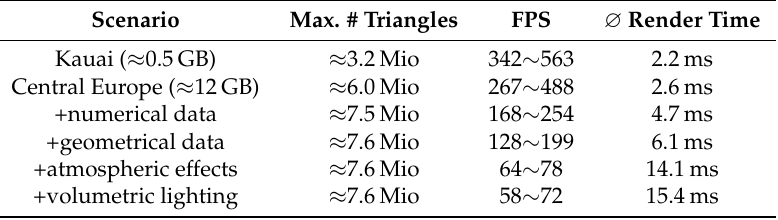
Table 1. Benchmark tests of T EDA V IS under different visualization scenarios. The table shows the minimum and maximum render frame-rates per second (FPS) and the resulting average render time for 1080p images as well as the number of rendered triangles.